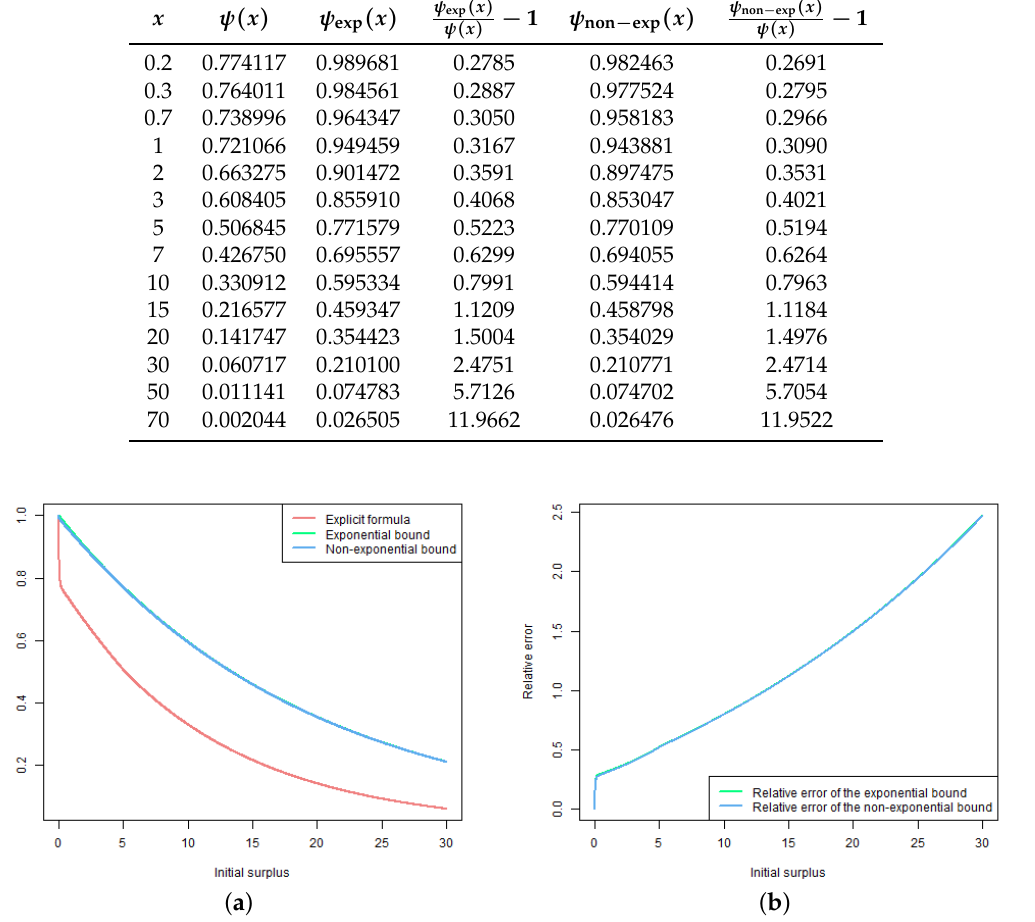
Figure 3. Comparison of the results for the model considered in Example 3: ( a ) Ruin probability given by the explicit formula as well as the exponential and non-exponential bounds for it. ( b ) Relative errors of the exponential and non-exponential